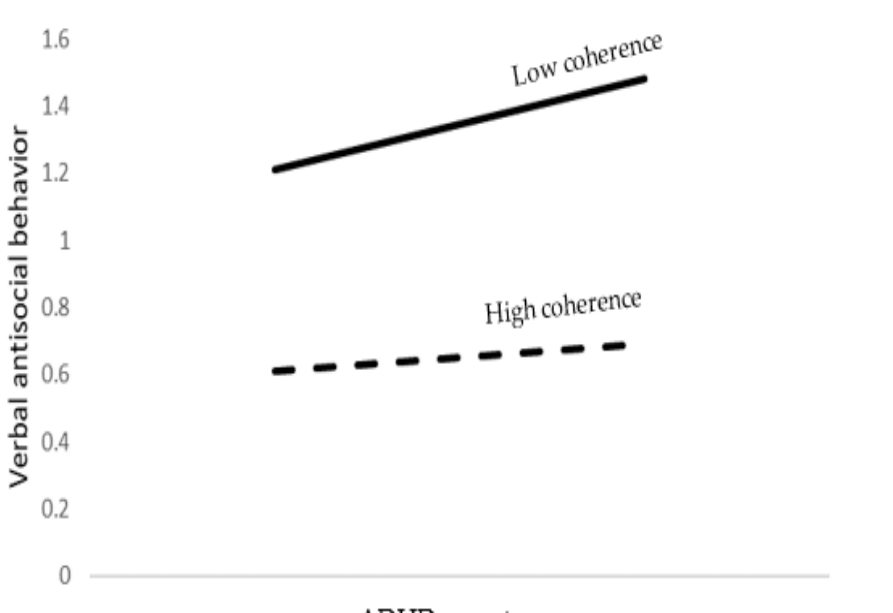
Figure 3. The association between ADHD symptoms and verbal antisocial behavior as moderated by coherence. The tested model accounted for 12% of the variance in property crimes. As shown in Table 6, young age, male gender, lower religiosity levels, lower emotional symptoms, higher ADHD symptoms, and lower coherence were significant predictors of property crimes. As expected, a significant ADHD symptoms by coherence interaction was found. As shown at the bottom of Table 6 and Figure 4, ADHD symptoms predicted property crimes when coherence was low but not when high. Table 6. ADHD as a predictor of property crimes moderated by coherence.